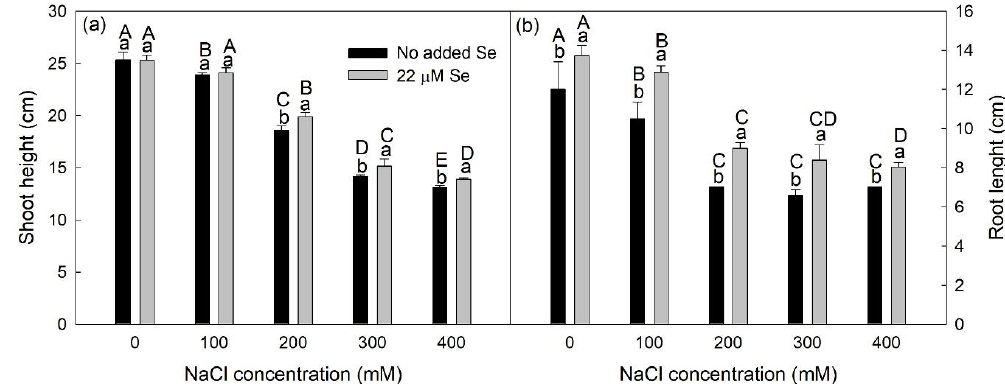
Figure 1. Means ± SD ( n = 5) of the shoot height ( a ) and root length ( b ) of untreated seedlings (No Figure 1. added Se) and Se-treated seedlings (22 µ M Se) under di ff erent NaCl concentrations. Values followed by di ff erent letters statistically significantly di ff er at p < 0.05. Means with di ff erent lowercase letters significantly di ff er by a t -test between Se treatments (No added Se and 22 µ M Se) at the same NaCl concentration. Means with di ff erent capital letters significantly di ff er by an LSD test under di ff erent NaCl concentrations in separate untreated and Se-treated groups ( p <